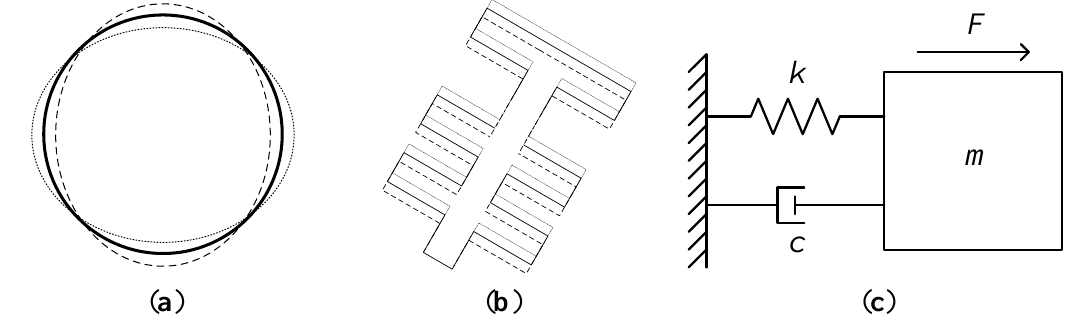
Figure 3. ( a ) Resonating disk structure, ( b ) resonating comb structure, and ( c ) resonant mass-spring-damper